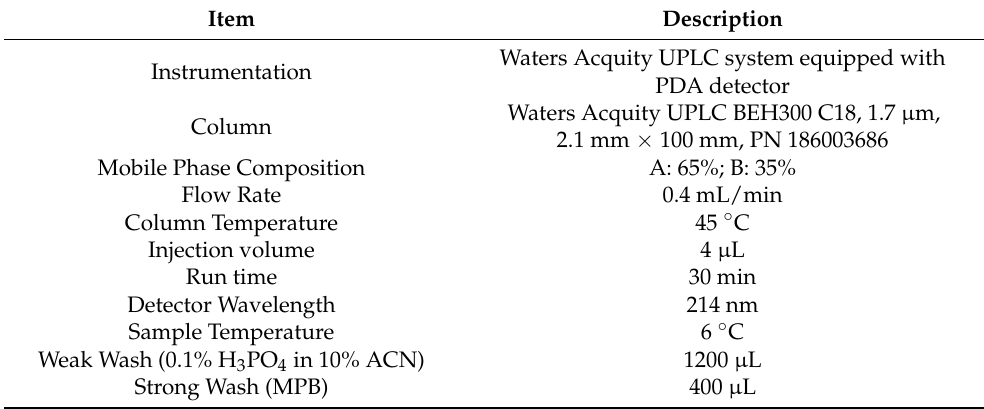
Table 2. UPLC system